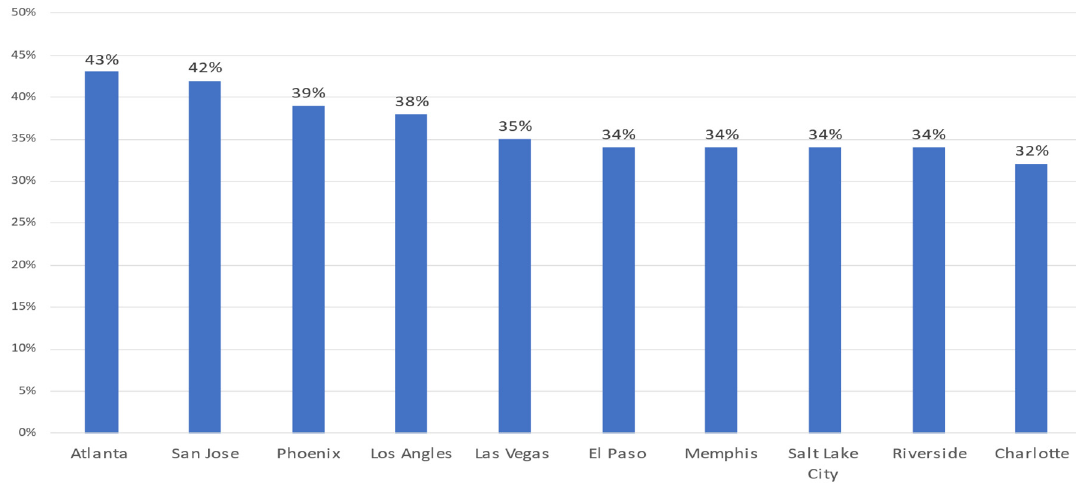
Figure 11. Highest Investor Share by Metro (Q3 2021). Source: Corelogic, Redfin.